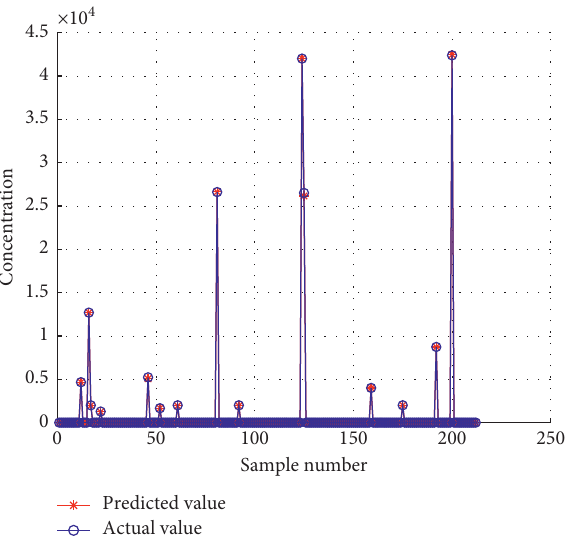
Figure 9: The Binzhou test set data prediction effect